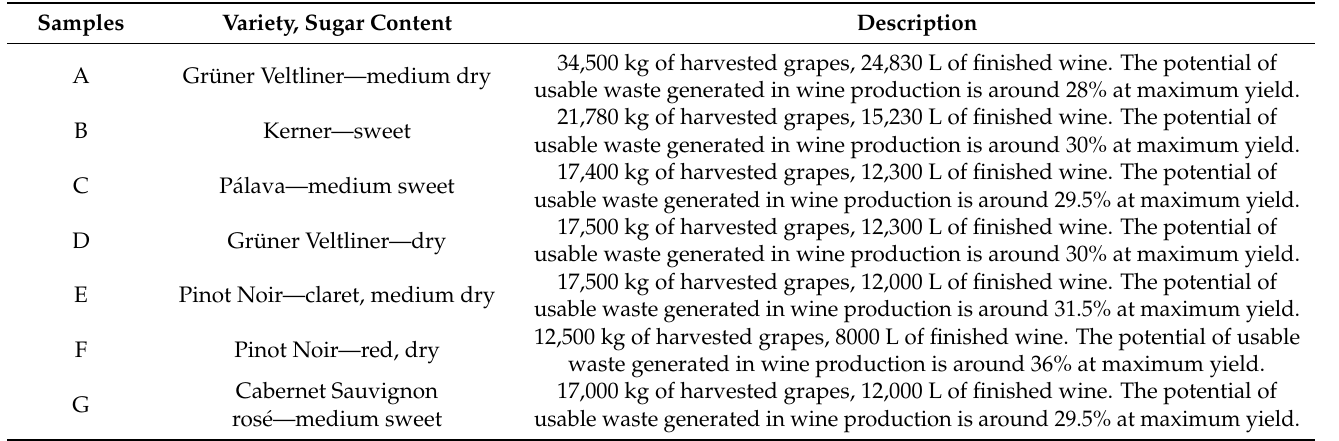
Table 4. Information in wine production of